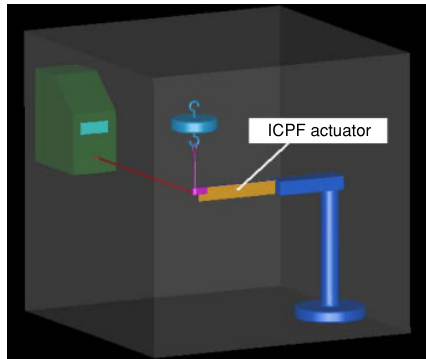
Figure 17 The upload ability measurement system simulating the driver’s state in Walker-2.